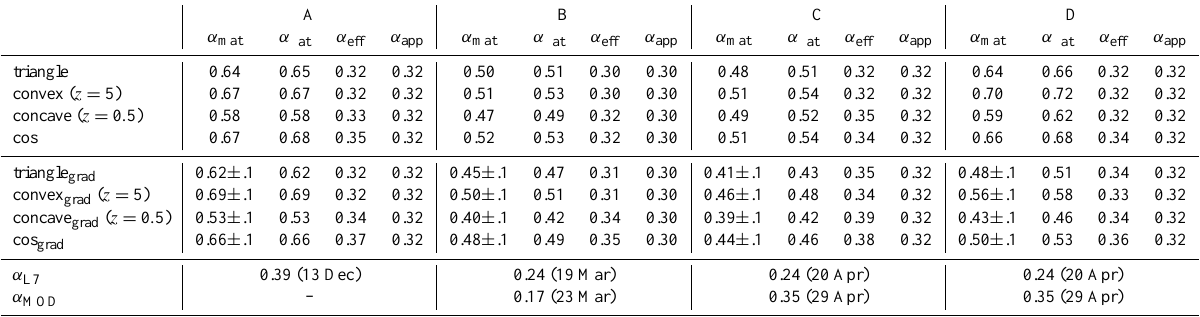
Table 4. Overview of material albedo α mat , flat surface albedo α flat , apparent albedo α app at h = 0, effective albedo α eff and satellite albedo ( α L7 and α MOD ) for each experiment and for the different shapes and assumptions on spatial variability in material albedo. The albedo gradients are based on the assumption that the penitente tips/bottoms have a material albedo which is 0.1 higher/lower than the mean material albedo and that there is a linear gradient between them. The satellite albedos also mention the closest acquisition date that corresponds to the four experiments. MODIS and Landsat acquisition times are around 10:30 and 10:00LST at the Equator,